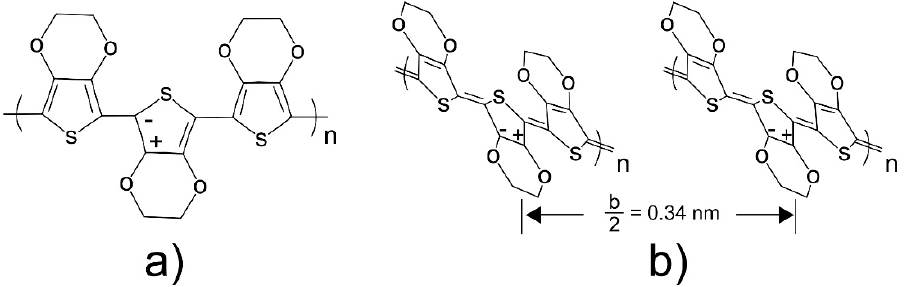
Figure 10. Chemical structures of the ( a ) benzoid and ( b ) quinoid forms of